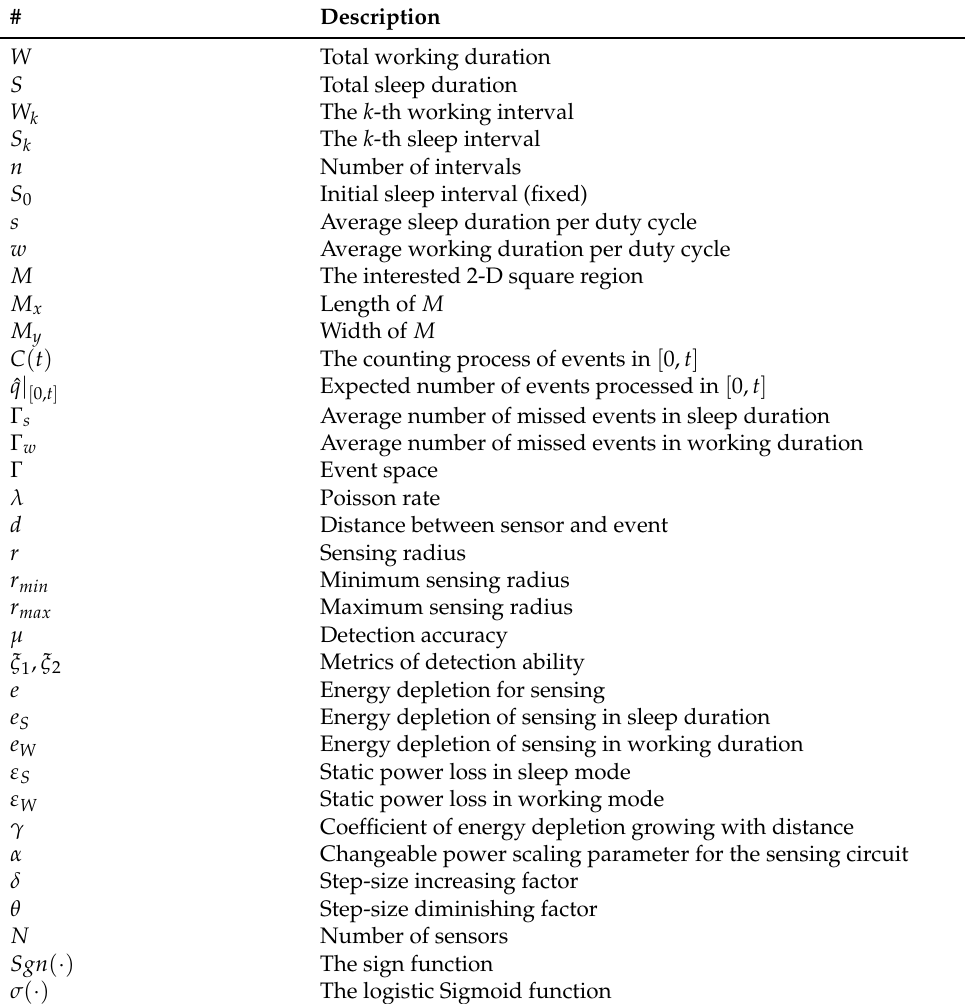
Table 4. List of essential notations in the model